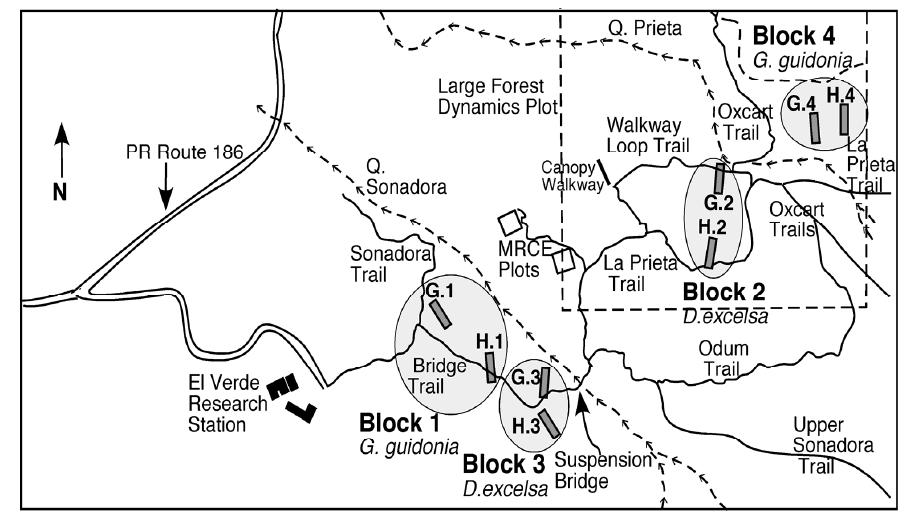
Figure 1. Section of the El Verde Research Area in the Luquillo Experimental Forest of Puerto Rico where this study was conducted, showing the four blocks, each with a pair of logs belonging to two different hurricane cohorts (Hurricane Hugo in 1989 and Hurricane Georges in 1998). The first letter of the log code refers to the hurricane (G for Georges and H for Hugo) while the number refers to the block. Logs in two of the blocks were Dacryodes excelsa Vahl. While the logs in the other two blocks were Guarea guidonia (L.) Sleumer. Direction of stream flow in the Quebrada Prieta and Quebrada Sonadora is indicated by arrows. The logs are not shown to scale.